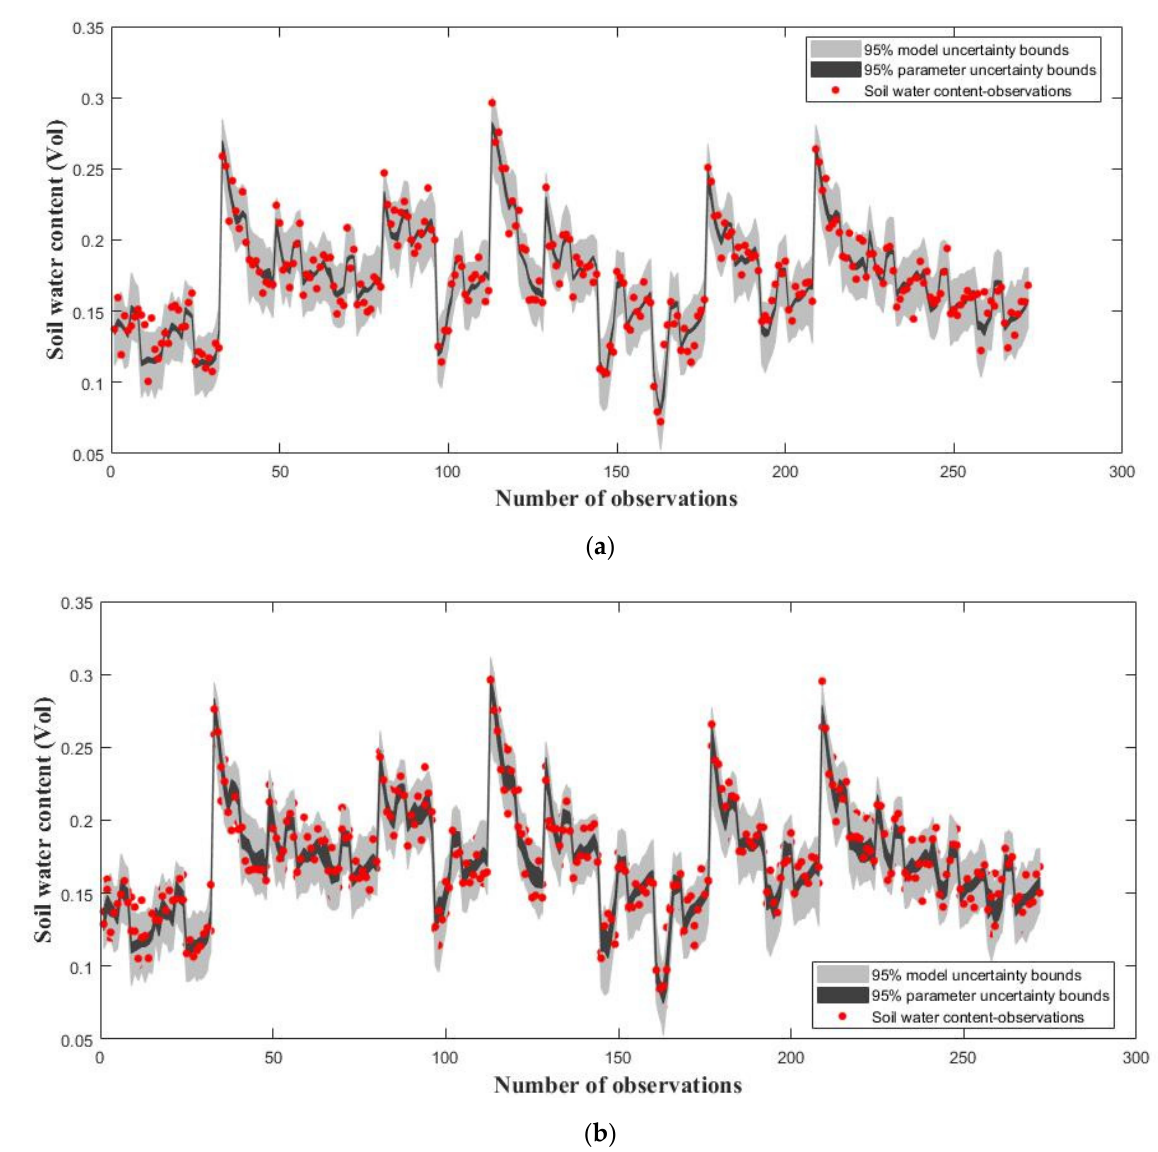
Figure 1. Plots of simulated and reference soil water content. 95% simulation uncertainty intervals due to parameter (dark region) and total uncertainty (light gray). The reference soil water content values are indicated with red points. ( a ) iterative local updating ensemble smoother (ILUES); ( b ) ensemble smoother multiple data assimilation (ESMDA).